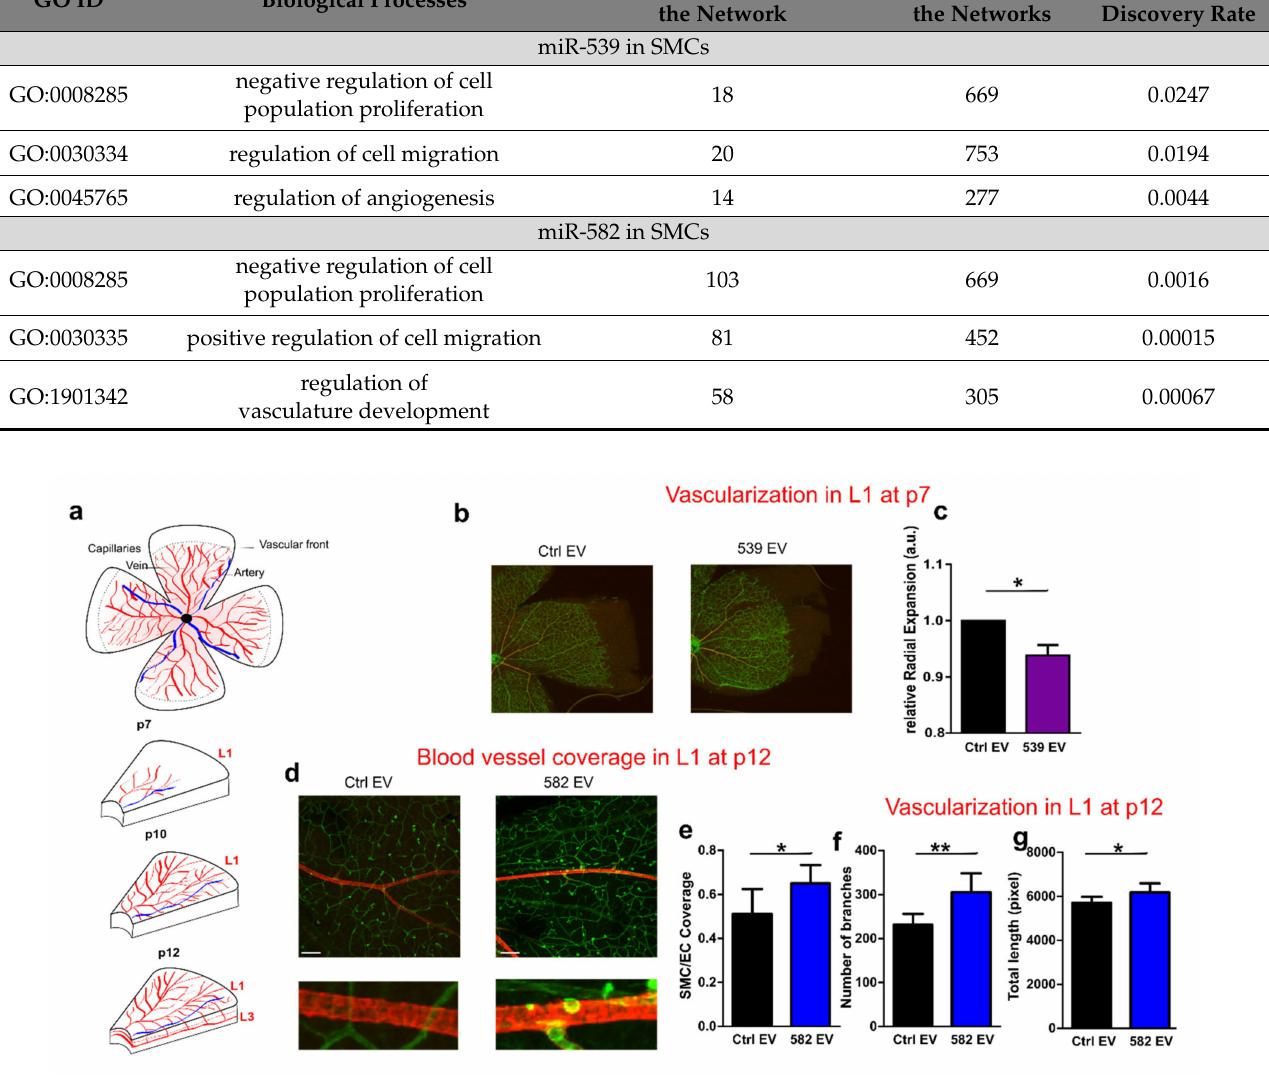
Figure 5. miR-539 EVs and miR-582 EVs participate in vascular remodeling of the retina. ( a ) Cartoon illustrating the development of the superficial (L1), intermediate (L2), and deep vascular plexus (L3). ( b ) Left: retinal flat mount representation. For ( b – g ), EVs were purified from ECs transfected with pre-miR-539 (539 EV) or a pre-miR-Control (Ctrl EV) or from SMCs transfected with pre-miR-582 (582 EV) on a pre-miR-control (Ctrl EV) ( b ) Isolectin-B4 staining on Postnatal Day 7 retinas from pups that were injected at Postnatal Day 1 with EVs. Scale bar: 25 µ m. ( f – h ). The histograms represent the quantification of the radial expansion from the optic nerve to the vascular front ( c ), N = 8 eyes, two independent experiments. ( d ) Confocal images of isolectin-B4/ α -SMA staining on postnatal Day 12 retinas from pups that were injected at Postnatal Day 7 with miR-582 EVs in the superficial layer (L1). Scale bar: 200 µ m. ( e – g ). The histograms represent the quantification of the coverage of ECs by SMCs (Spearman’s rank correlation value) ( e ), the number of branches ( f ), and the total length of isolectin+ vessels ( g ) * p < 0.05, ** p =